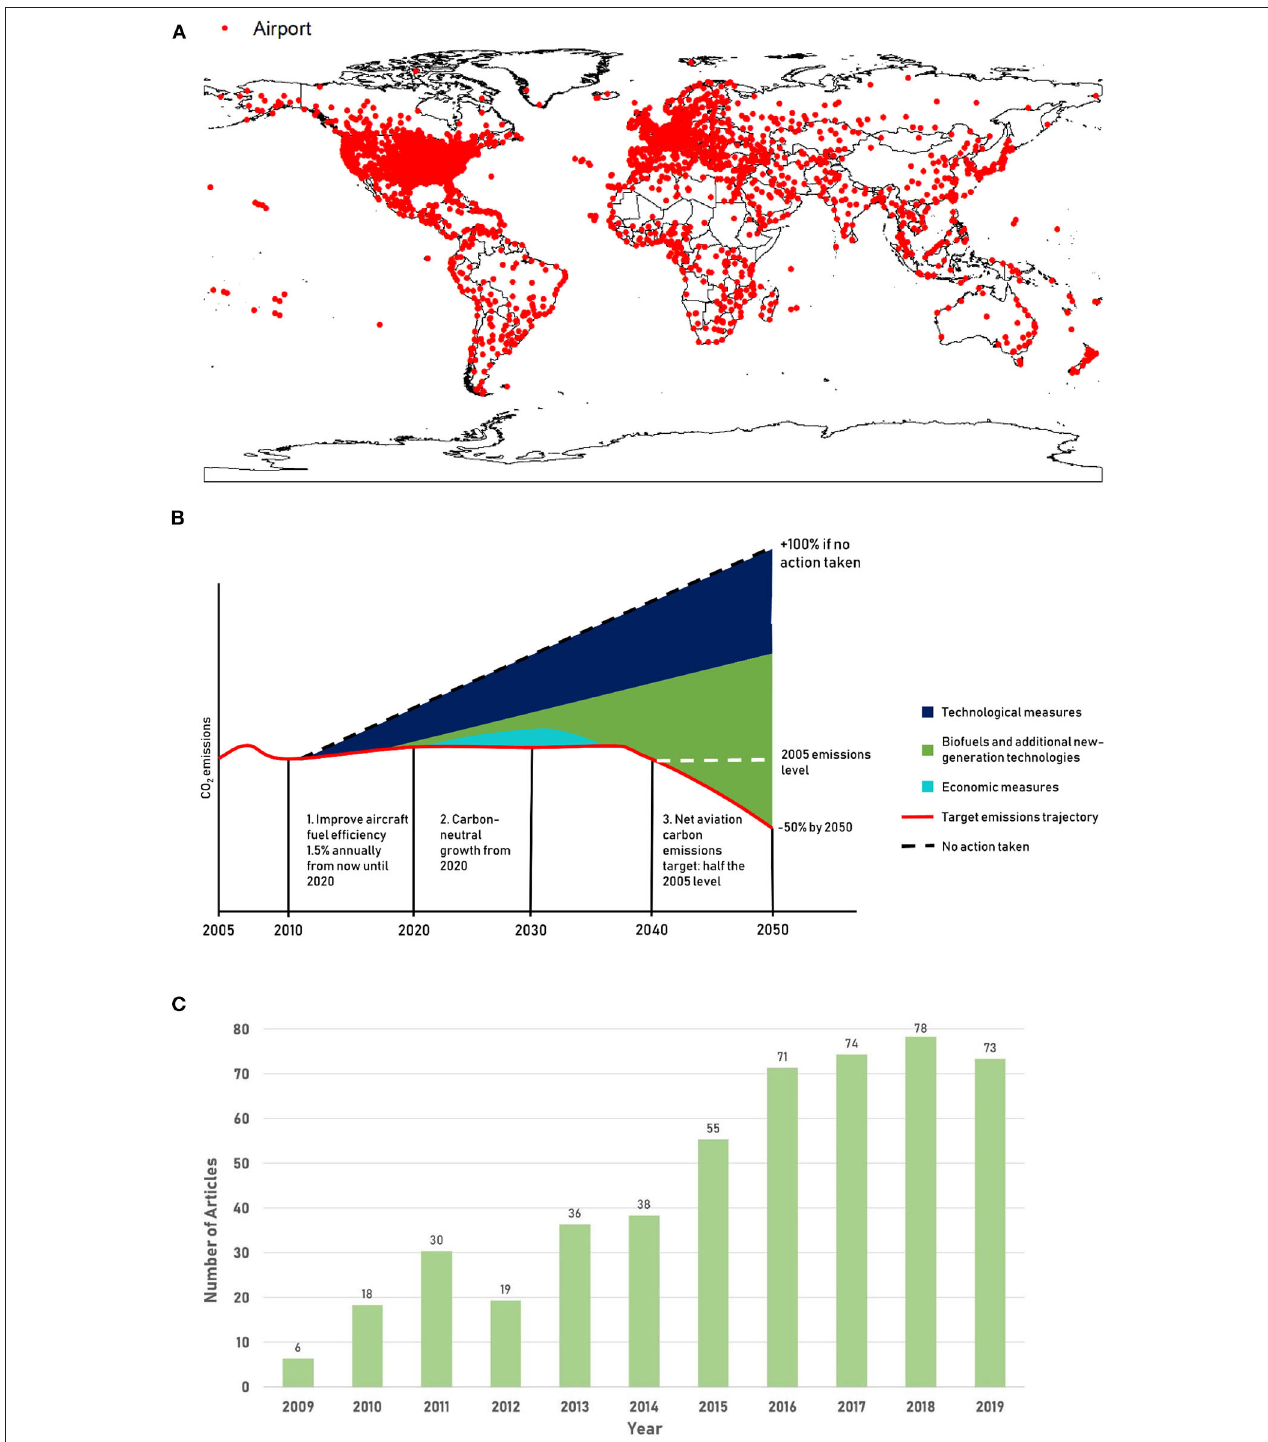
FIGURE 1 | Recent trends for the the aviation industry: (A) Global Airport Distribution (Plotted using data from www.arcgis.com, 2019); (B) Potential global atmospheric CO 2 emissions released by the aviation sector under various development conditions (IATA, 2009); and (C) Publication history on bio-aviation fuel research (Plotted using data from Scopus accessed on January 17, 2020).